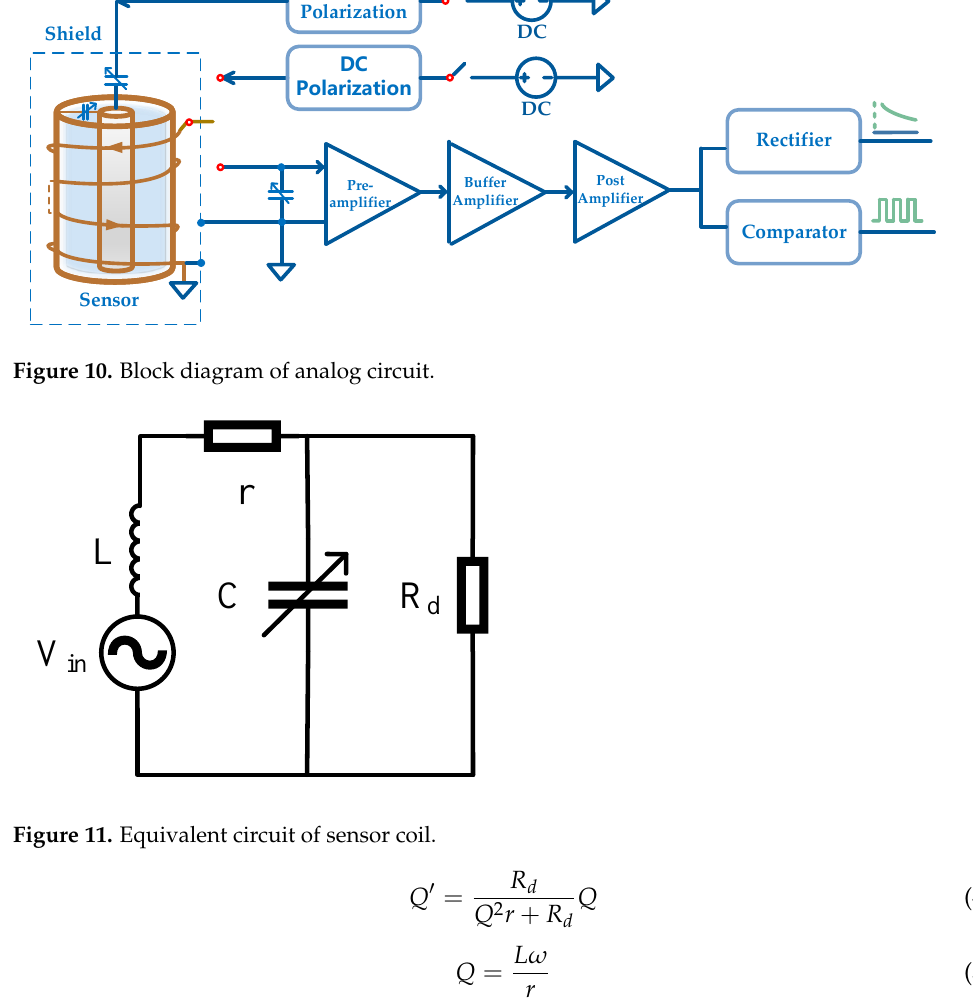
DSOX3054T CH3 Figure 12. Schematic of envelope signal and shaping signal test.